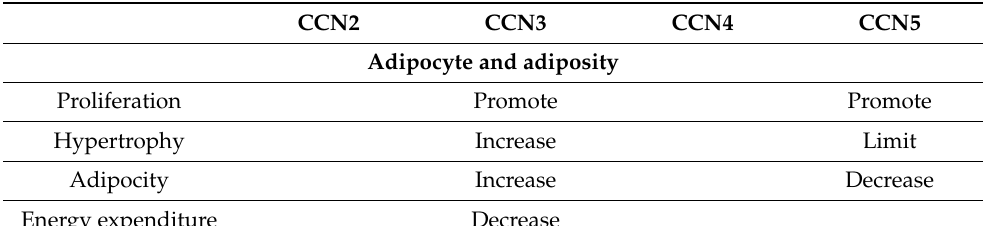
Table 2. Differential roles played by CCN proteins in obesity, fibrosis, and pancreatic islets. Qual- itative roles are summarized based on gain- and loss-of-function experiments; see text in Section 4 for details and original